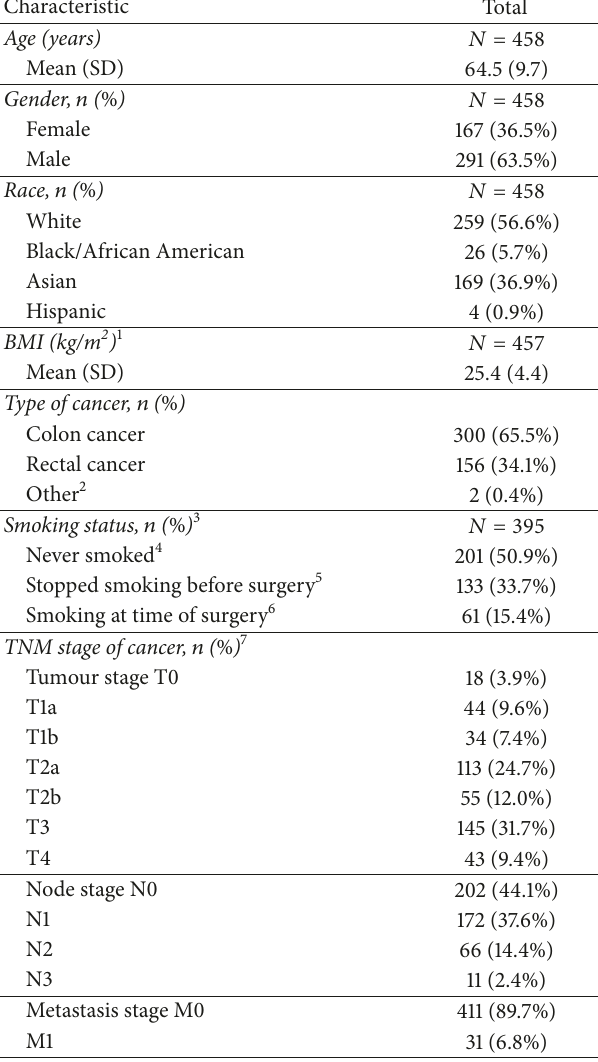
Table 1: Summary of patients’ demographic and disease character-